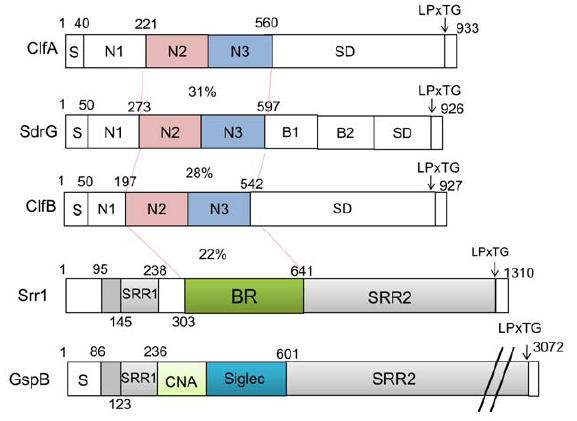
Figure 1. Schematic diagram of three staphylococcal fibrino- gen binding proteins (ClfA, SdrG and ClfB) and the serine rich repeat proteins Srr1 and GspB. Level of identity (%) between regions is indicated. *S: signal sequence; N1, N2, and N3: DEv-IgG domains; B1 and B2, repeats of unknown function; SD: serine and aspartic acid rich region; SRR1 and SRR2: serine rich regions; CNA: IgG fold domain; Siglec: sialic acid binding domain; LPxTG: cell wall anchoring